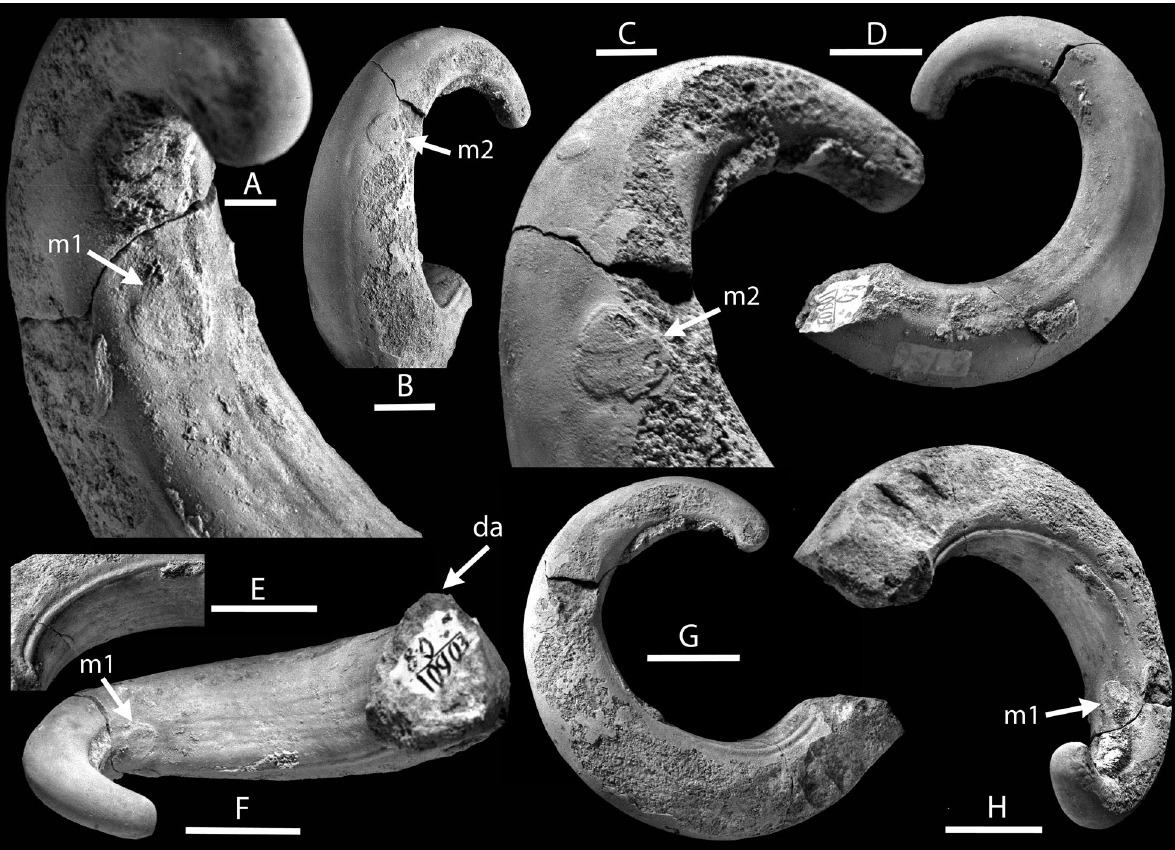
Fig. 1. Asgardaspira evolvens (Koken, 1897), CNIGRM 5756 (80/10903), internal mould; A , detail of umbilical wall showing muscle attachment scar (m1); B , oblique basal view showing spiral trace on outer whorl surface and muscle attachment scar m2; C , detail of muscle attachment scar m2; D , upper surface showing broad dorsal ridge; E , detail of circumbilical ridge and groove complex; F , standard orientation of dextral hyperstrophic shell, showing location of muscle attachment scar m1 and the dorsal angulation (da); G , basal surface; H , oblique umbilical view showing circumbilical ridge and groove complex and muscle attachment scar m1 (arrow). Scale bars: 2 mm (A, C); 4 mm (B); 10 mm